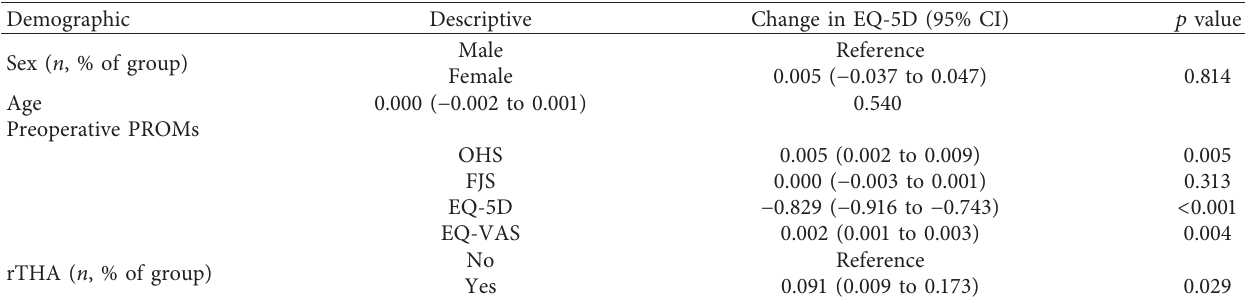
PROMs: patient-reported outcome